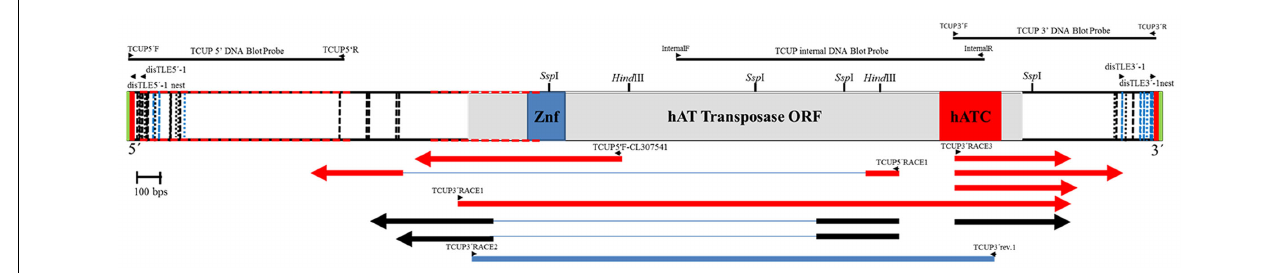
analysis in Figure 2 are noted on the diagram ( Swa I and Eco RI restriction enzyme do not cut within the TCUP sequence) and the location of the DNA gel blot probe sequences are represented as lines above the diagram. Primers used for RT-PCR related experiments and transposon display are represented as small arrowheads. RT-PCR and RACE related transcripts are represent below the DNA sequence with those derived from azadC treated callus cultures colored red while BMS derived sequences are colored black. Sequenced 5 (cid:2) RACE clones are represented by arrows facing the 5 (cid:2) direction and 3 (cid:2) RACE clones are represented by arrows facing in the 3 (cid:2) direction.The 2.15-kb predicted RT-PCR amplicon derived from the primers utilized in Figure 6 is represented as a blue bar underneath the sequenced RACE